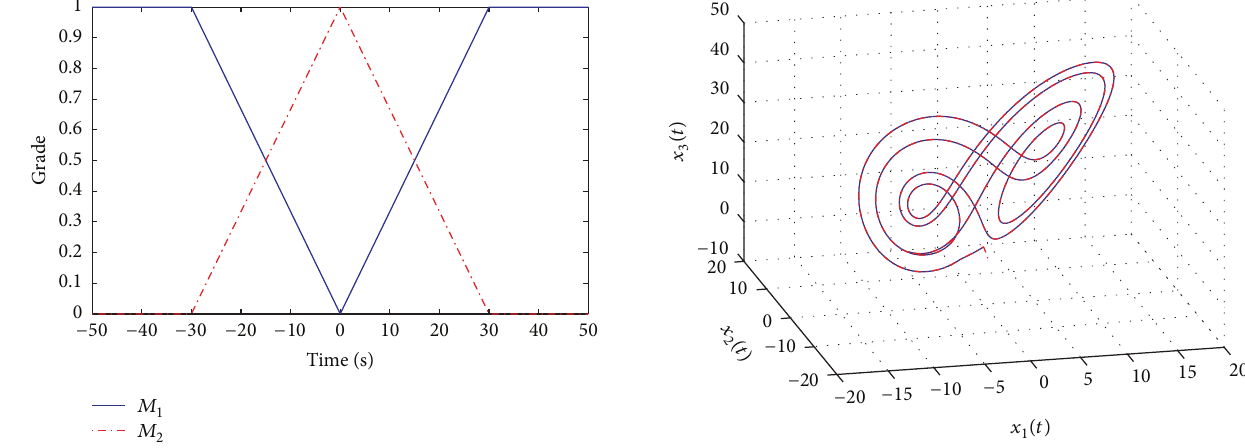
Figure 4: Membership functions of the fuzzy controller.